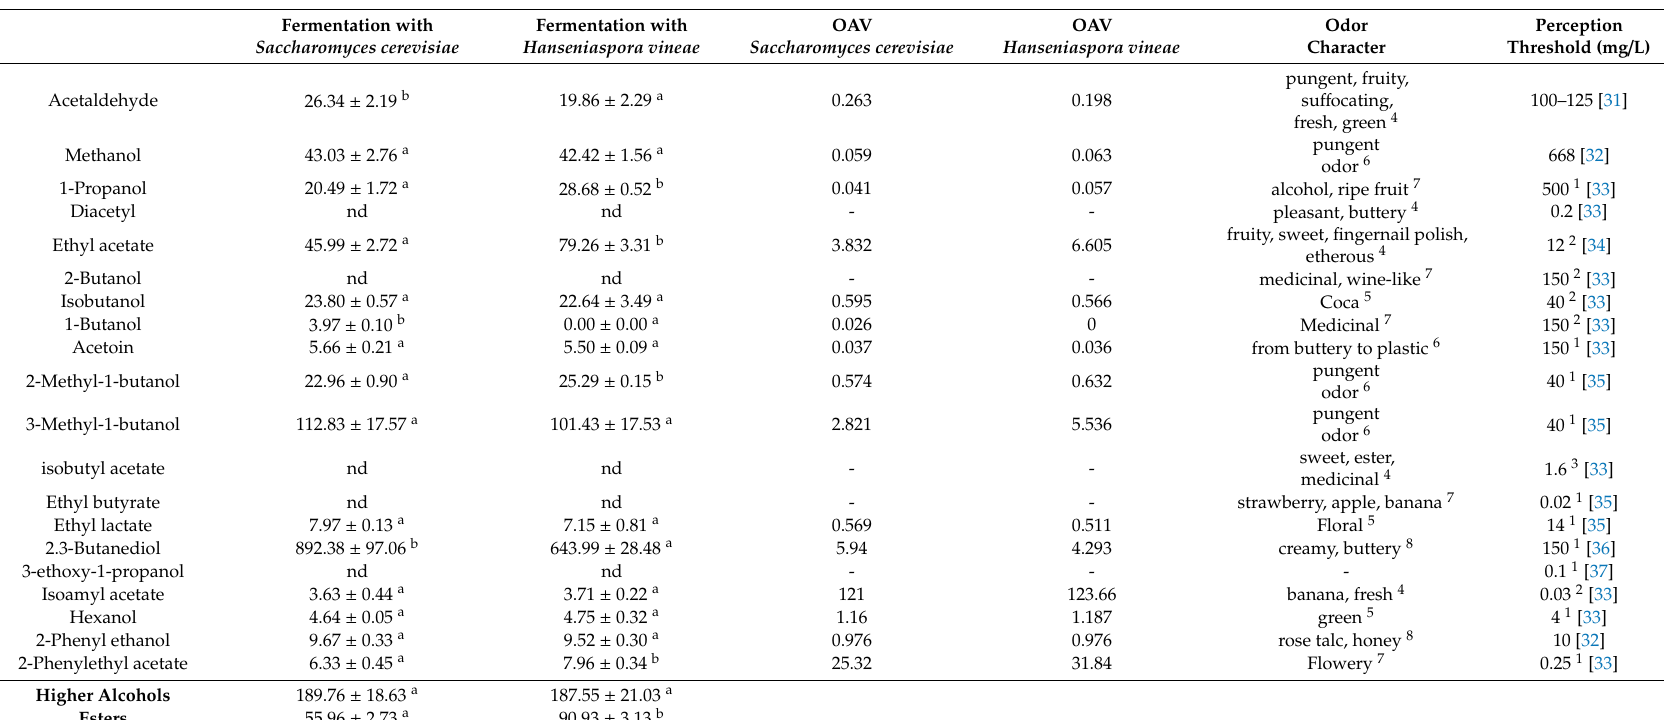
Table 3. Concentration of volatile compounds produced by fermentation (mg / L), measured by GC-FID. Mean ± standard deviation of three replicates. Di ff erent letters indicate values with statistical significant di ff erences ( p <